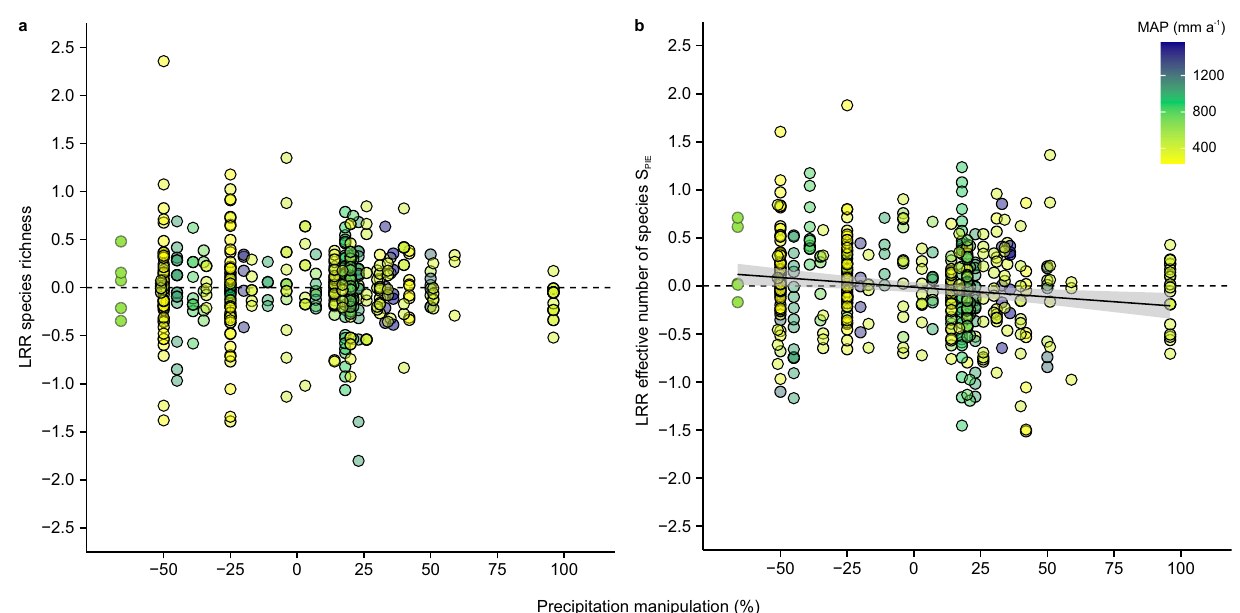
Fig. 2 Responses of plant diversity to precipitation manipulation at the turnover scale. Effect of the magnitude of precipitation manipulation on the log response ratio (LRR) of species richness ( a ) and effective number of species — S PIE ( b ) at the turnover scale (i.e., plot to plot scale). Data points represent log response ratios of original data ( n = 462) and colors indicate the background mean annual precipitation (MAP). The linear regressions (mean and 95% con fi dence intervals) are based on predicted values of the simplest linear mixed effect model including magnitude of precipitation manipulation (Supplementary Tables 2 and